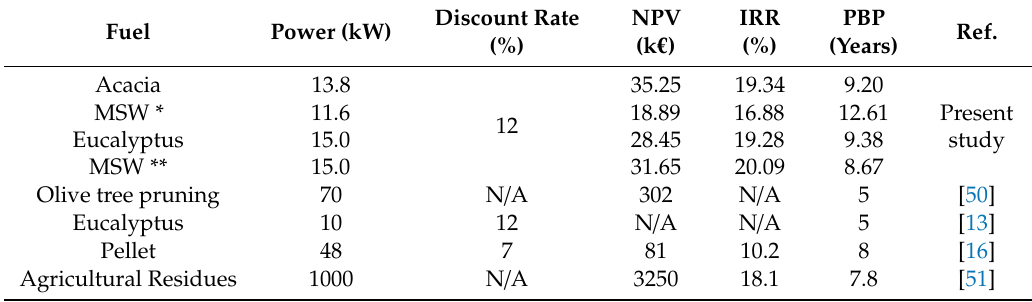
Table 11. Record of downdraft gasifiers’ economic analysis results found in the literature suiting as means to of comparison for this